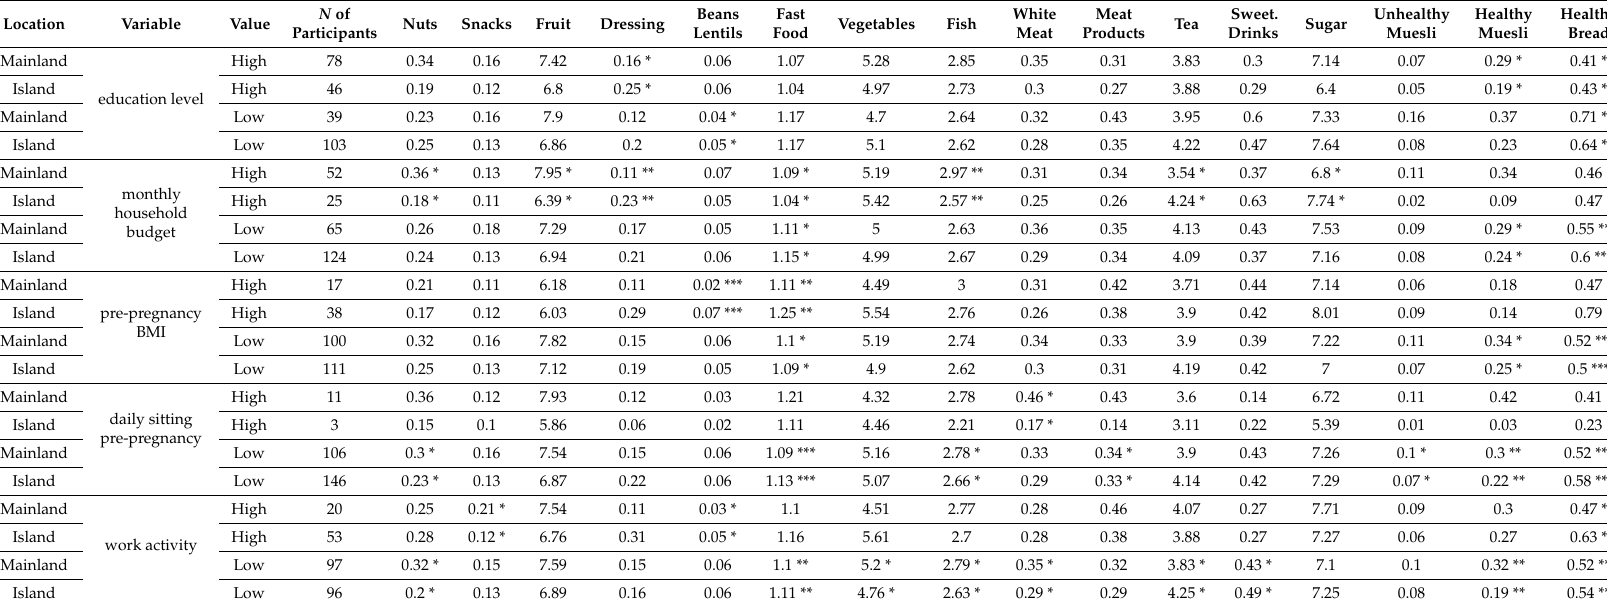
Table 5. Cumulative frequencies of food items with regards to location and other relevant maternal socioeconomic and lifestyle factors (mean values are converted to high-low values with level of significance for the location tested by the Mann–Whitney U (MWU) test (* p < 0.05, ** p < 0.01, *** p < 0.001; only cumulative frequencies with at least one significant di ff erence were taken into